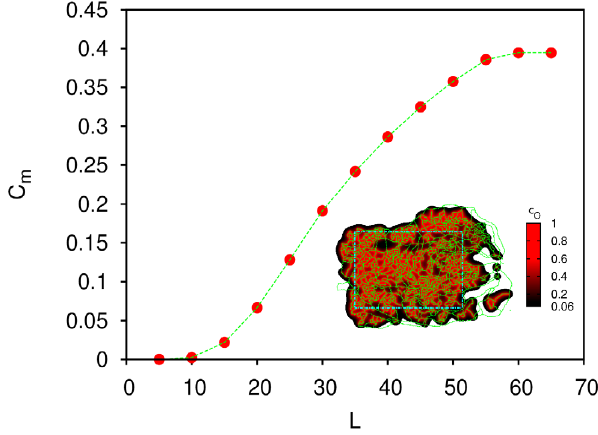
Figure 2. Plot of the C m required for the normoxia of all tissue inside the rectangle (inset) as a function of the diffusion length of oxygen, L . Inset: In this diagram we represent the vascular network analyzed (in green), the c O in the retina (in the gradient black-red) for L ~ 20 lattice units and C m ~ 0 : 06 , and the boundary of the region of the retina analyzed in this work (in turquoise).